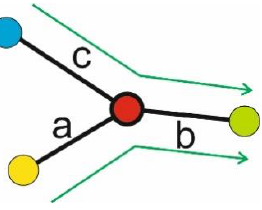
Figure 8. Example for the combination of link sequences 𝑎𝑏̅̅̅ and 𝑐𝑏̅̅̅ with 𝑤(∡(𝑐,𝑏)), 𝑤(∡(𝑏, 𝑏)) = 1 , 𝑤(∡(𝑎, 𝑏)), 𝑤(∡(𝑎,𝑐)) = 10 and 𝑐𝑓(𝑎𝑏̅̅̅, 𝑐𝑏̅̅̅) = 5.5 .